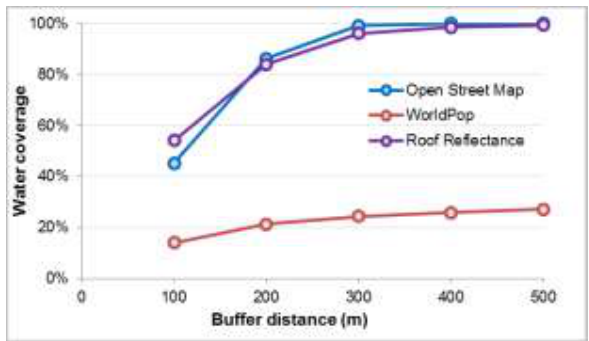
Figure 5: Interpolated iron (A), total dissolved solids (B) and total hardness (C) concentrations in groundwater